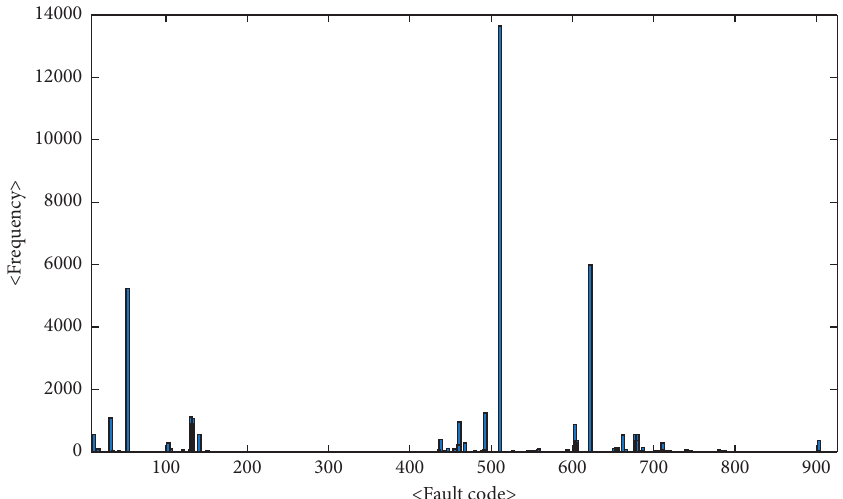
Figure 3: Defect frequency (each fault code is designated by Korean Railroad Research Institute).